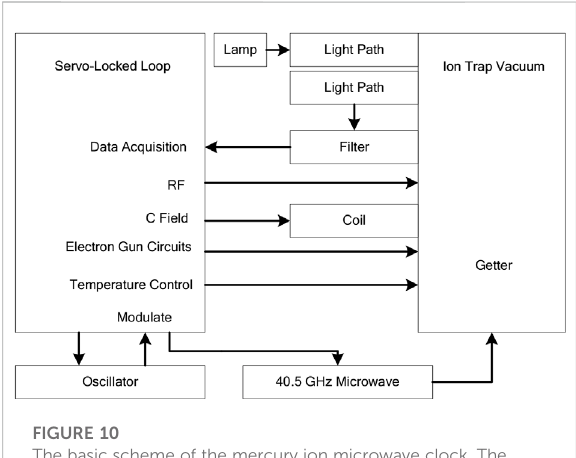
FIGURE 10 The basic scheme of the mercury ion microwave clock. The mercury ions are trapped by the linear ion trap inside a vacuum tube.A40.5 GHzmicrowavesourceisusedtoexcitetheionsfrom the lower clock state to the upper clock state. The servo- locked loop locks the oscillator to the 199 Hg + clock transition.